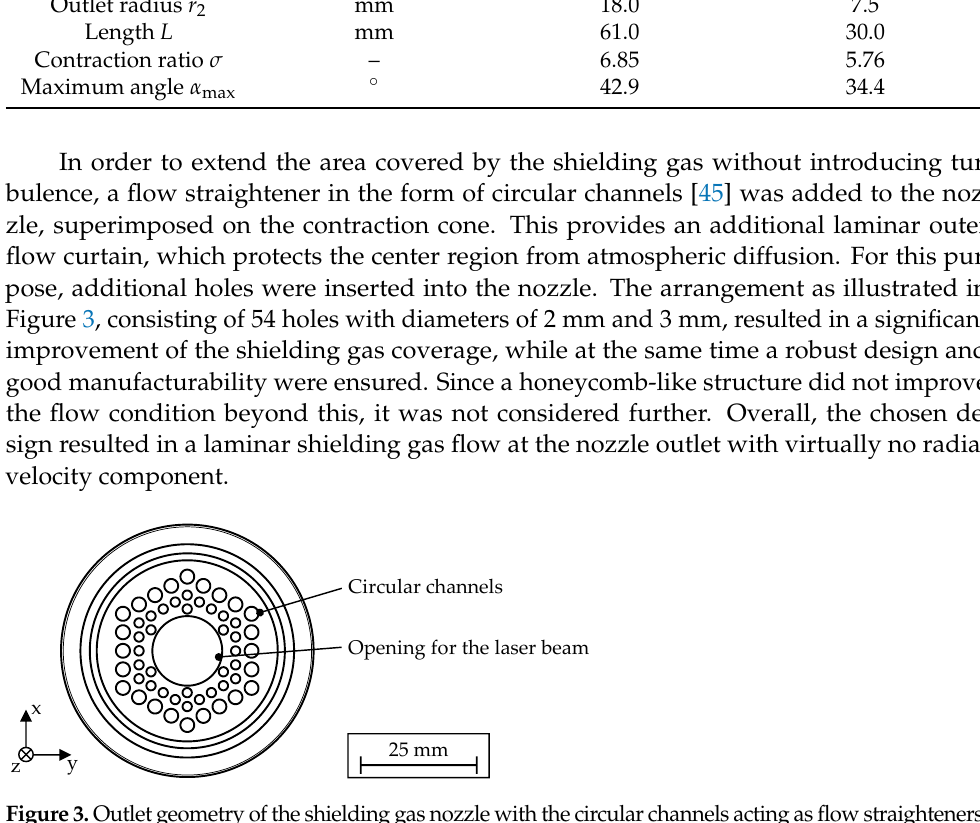
Figure 3. Outlet geometry of the shielding gas nozzle with the circular channels acting as flow straighteners.